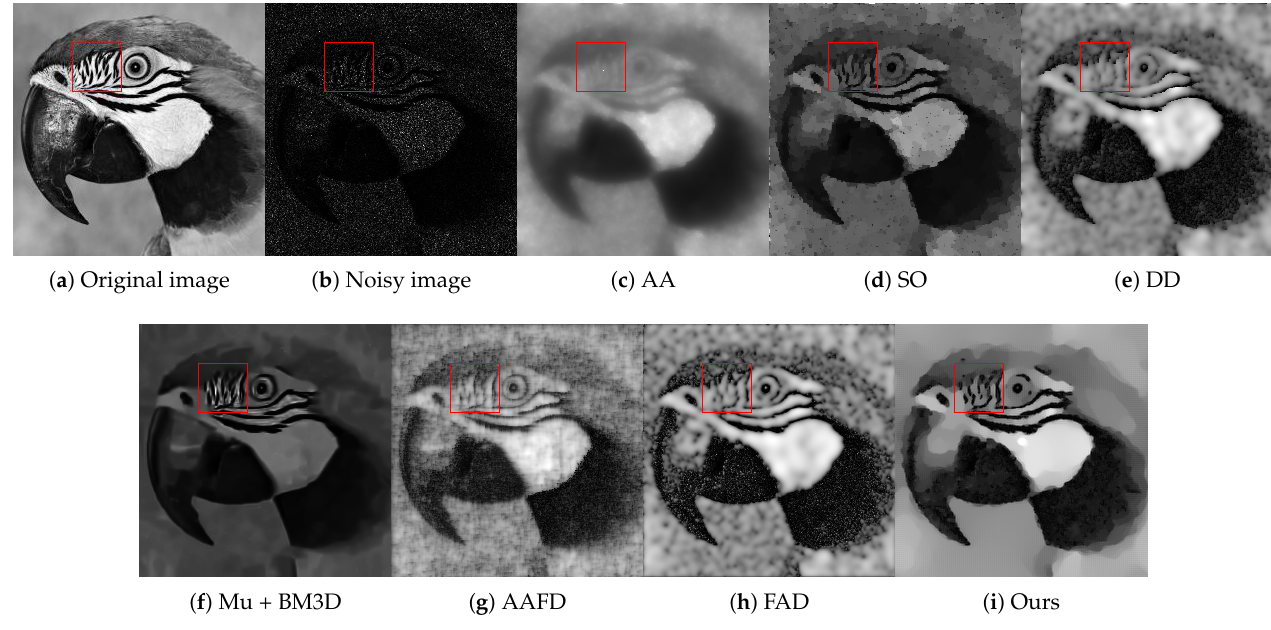
Figure 6. ( b ) Noisy: L = 1. ( c – i ) Denoised results.